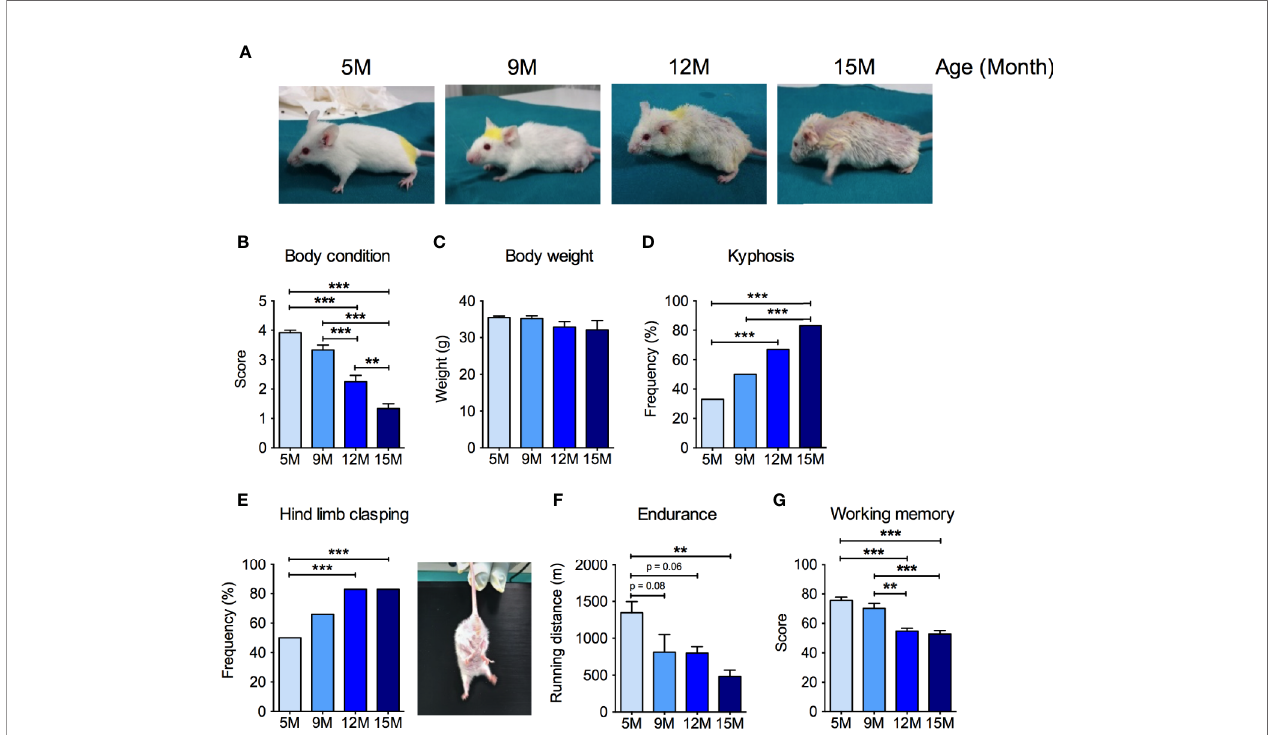
FIGURE 1 | Neuromuscular and cognitive phenotypical characterization of SAMP8 mice at different ages. (A) Representative pictures of SAMP8 mice at 5, 9, 12, and 15 months of age show a progressive appearance of signs of aging, which were quanti fi ed by means of body condition score (B) , body weight (C) , frequency of kyphosis (D) , and frequency of hind limb clasping re fl ex (E) . SAMP8 mice also showed a progressive reduction in exercise endurance measured by treadmill exhaustion test (F) , which was paralleled by a decline of working memory quanti fi ed by Y-maze test (G) . Statistical analyses were performed with one-way ANOVA and Tukey ’ s multiple comparison test (B , C , F , G) or Fisher test (D , E) . Error bars represent SEM; n=6 mice/group; **p < 0.01, ***p <